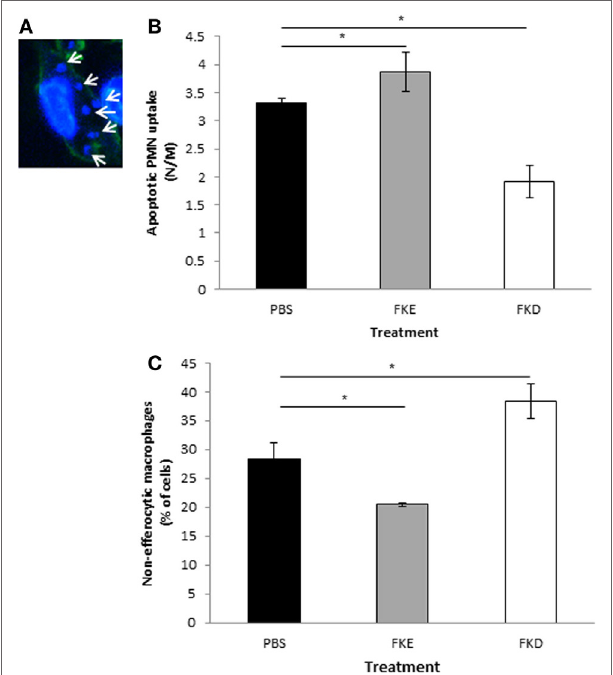
FigUre 4 | FKE peptides promote macrophage efferocytosis. Mice undergoing peritonitis for 48 h were injected intraperitoneally (i.p.) with PBS, FKE, or FKD peptides (50 µM each). After additional 18 h, peritoneal macrophages were isolated and stained with CF488A-conjugated phalloidin and Hoechst. Slides were visualized under a Nikon A1 confocal microscope and nuclei of engulfed polymorphonuclear cells (PMN) were enumerated [see (a) for a representative image]. Results show the average number of engulfed apoptotic PMN per macrophage (B) and the percentage of macrophages that did not engulf apoptotic PMN (c) . Results are averages ± SEM from three independent experiments ( n = 4 per group). *indicate statistically significant differences of P ≤ 0.05 by ANOVA with Tukey post hoc